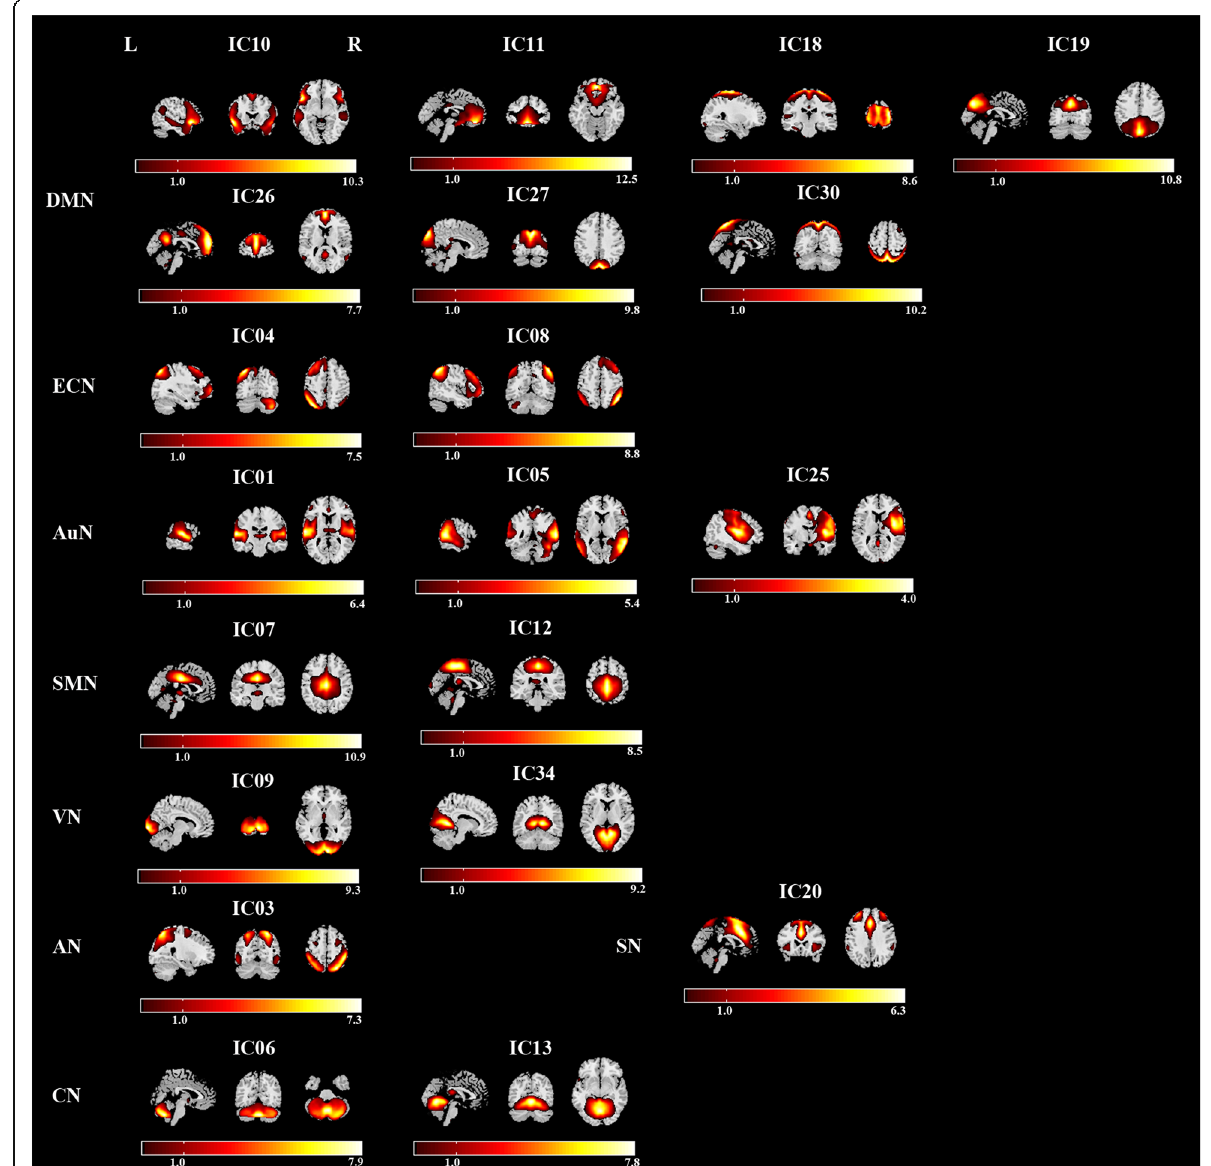
Fig. 1 Spatial maps (displayed at the three most informative slices) of 20 independent components (ICs) that have chosen as our networks of interest. R represent right and L represents left. DMN, default mode network; SMN, sensorimotor network; ECN, executive control network; AuN, auditory network; AN, attention network; SN, salience network; VN, visual network; CN, cerebellum